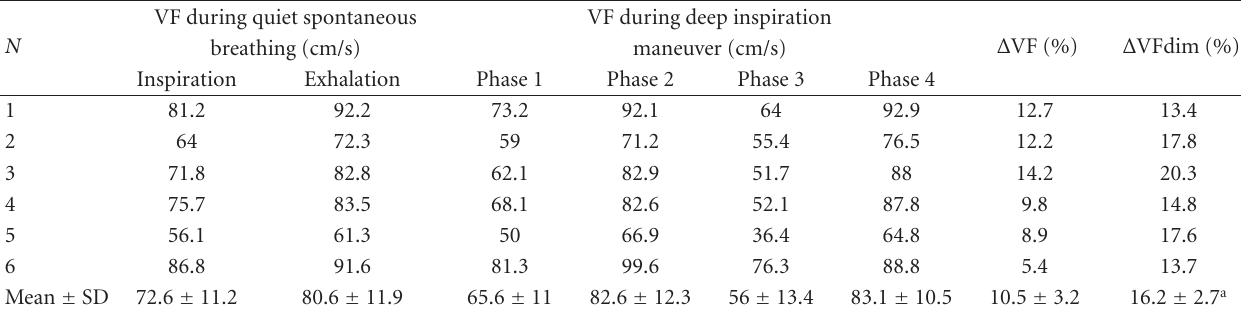
Δ VF (%) Δ VFdim (%)breathing